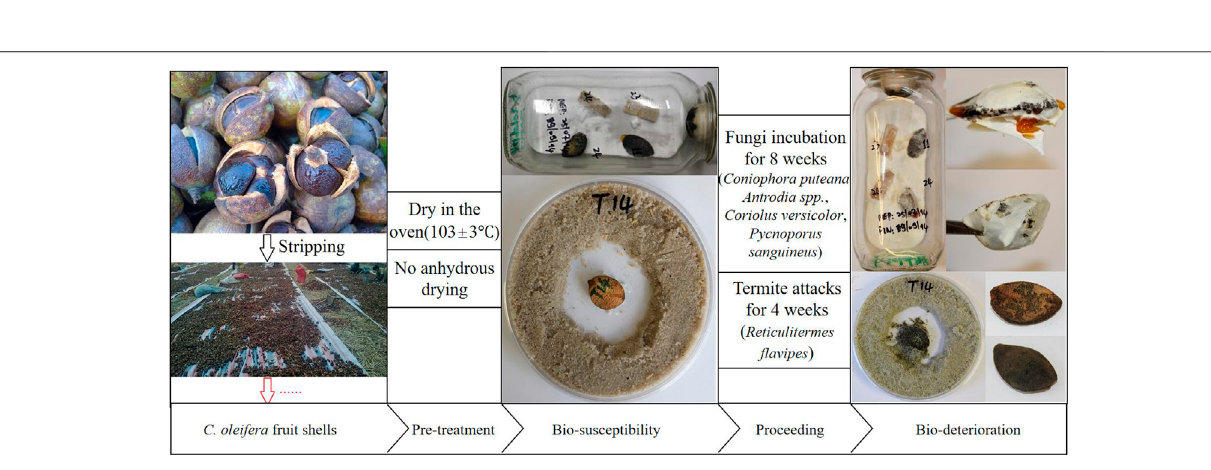
FIGURE 4 | Resistance of camellia shell powder to fungi and termites. Copyright 2015